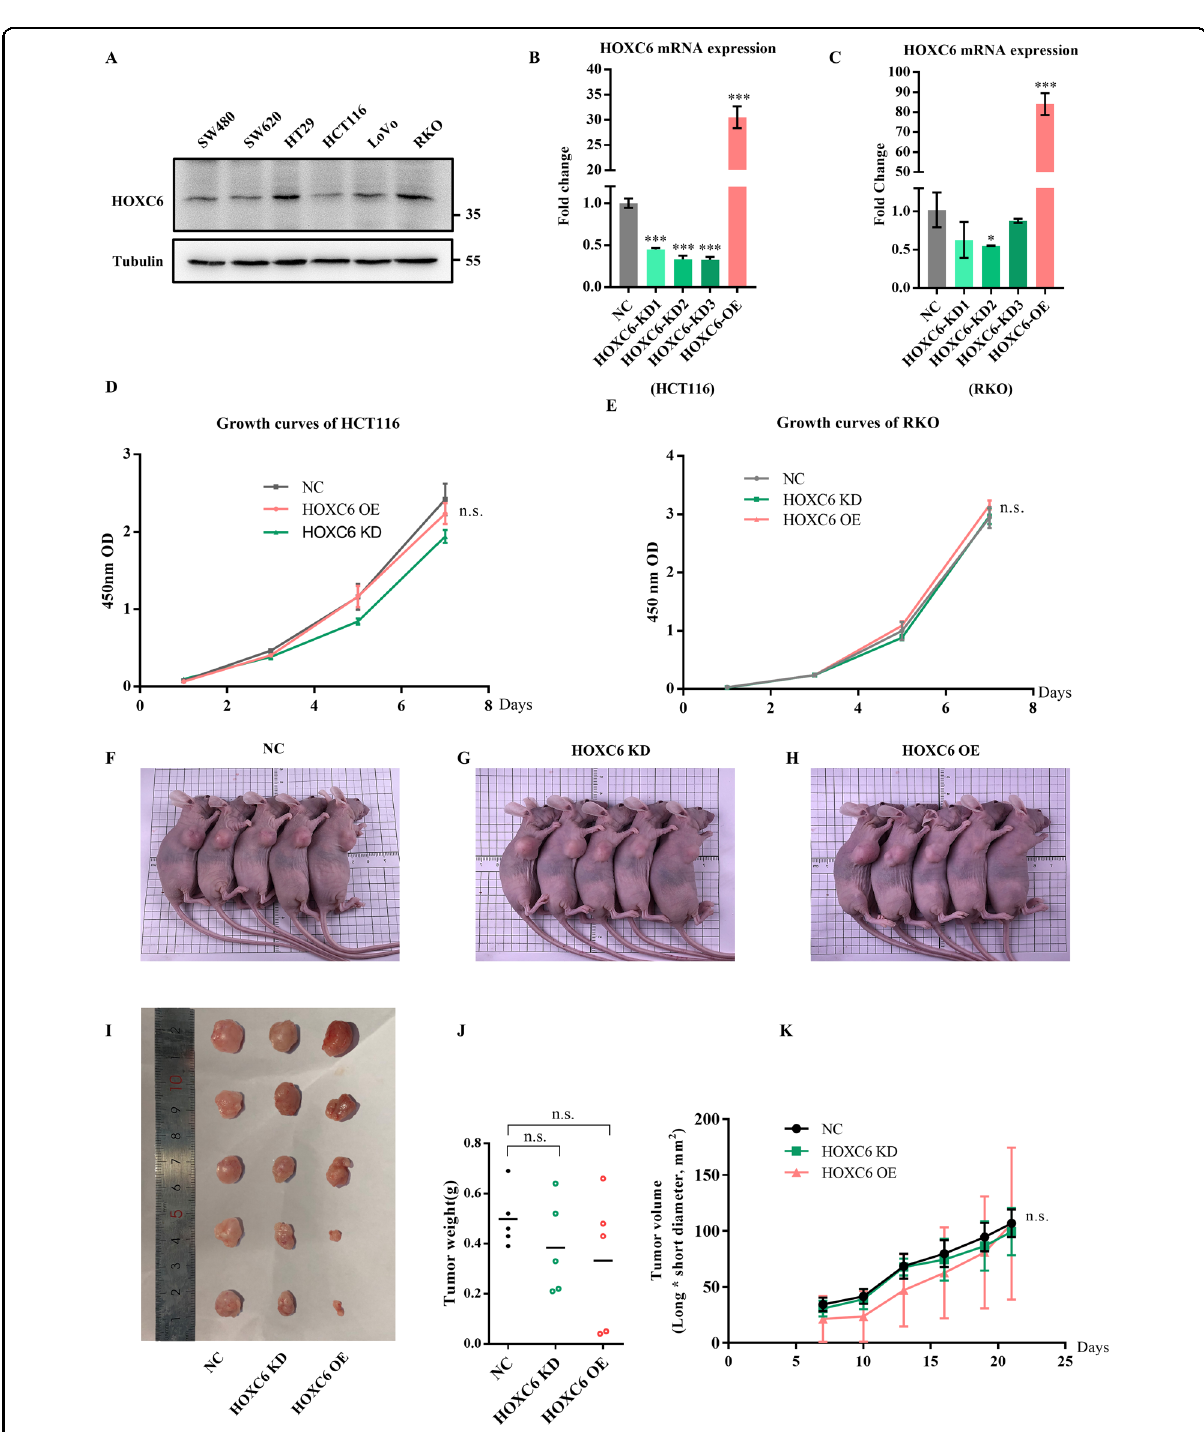
Fig. 2 HOXC6 did not alter proliferation ability of HCT116 and HT29 cells in vitro and in vivo. A Expression of HOXC6 in six CRC cell lines. B Identi fi cation of stable HOXC6 overexpression and knockdown in HCT116 cell lines using qRT-PCR. C Identi fi cation of stable HOXC6 overexpression and knockdown in RKO cell lines using qRT-PCR. D Growth curves of HCT116 cells in the NC, HOXC6-OE and HOXC6-KD groups. E Growth curves of RKO cells in the NC, HOXC6-OE and HOXC6-KD groups. F The subcutaneous NC HCT116 tumor cell injection mice. G The subcutaneous HOXC6-KD HCT116 tumor cell injection mice. H The subcutaneous HOXC6-OE HCT116 tumor cell injection mice. I The tumors dissected from NC, HOXC6-KD and HOXC6-OE mice. J The tumor wight for dissected tumors from NC, HOXC6-KD and HOXC6-OE mice groups. K The tumor growth curve evaluated by tumor long*short diameter for NC, HOXC6-KD and HOXC6-OE groups. * P < 0.05; *** P < 0.001; n.s.: no signi fi